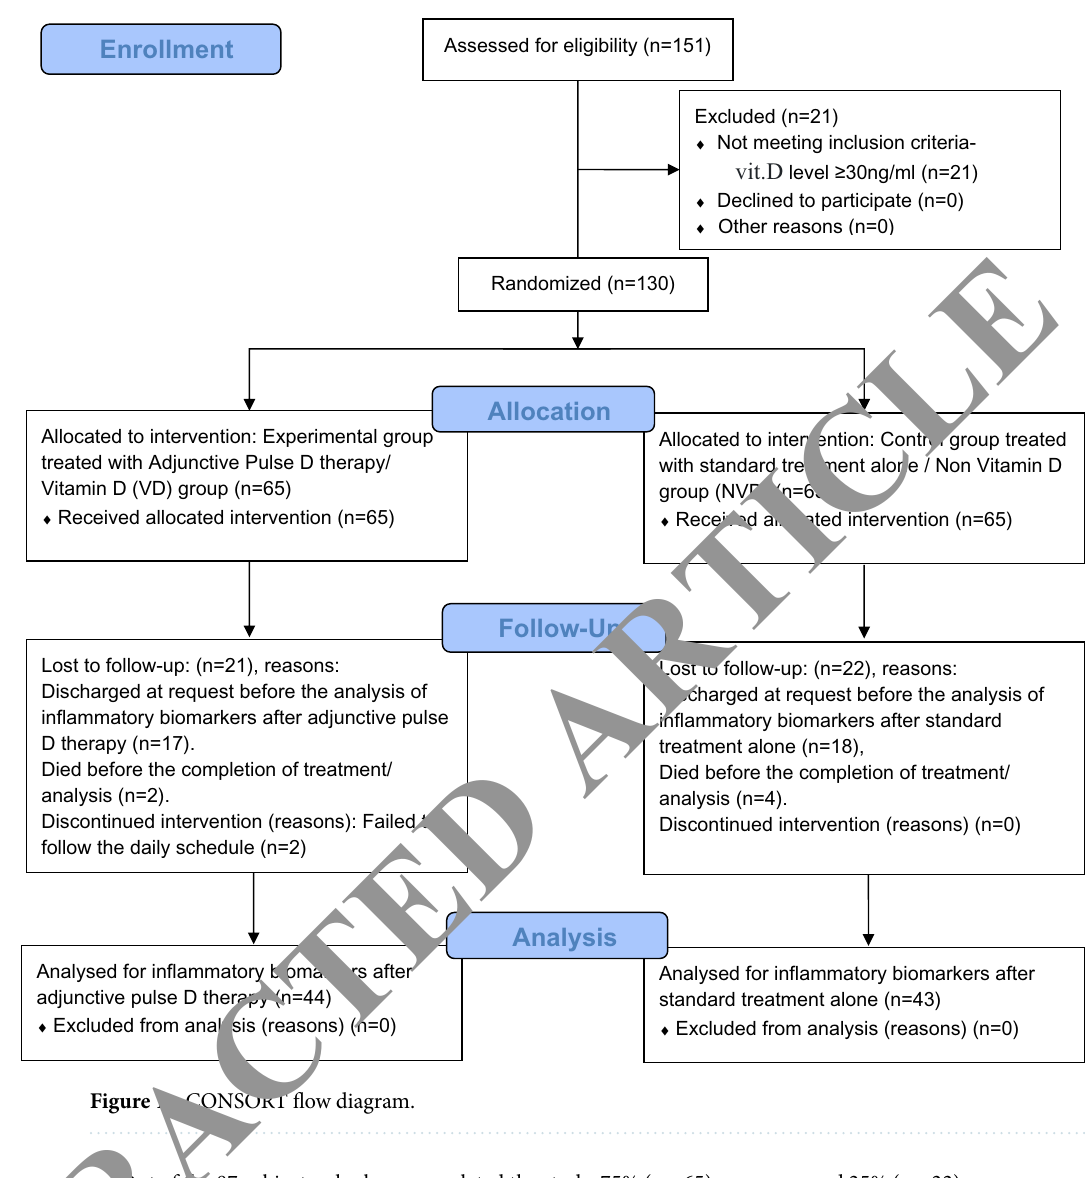
Figure 1. CONSORT flow